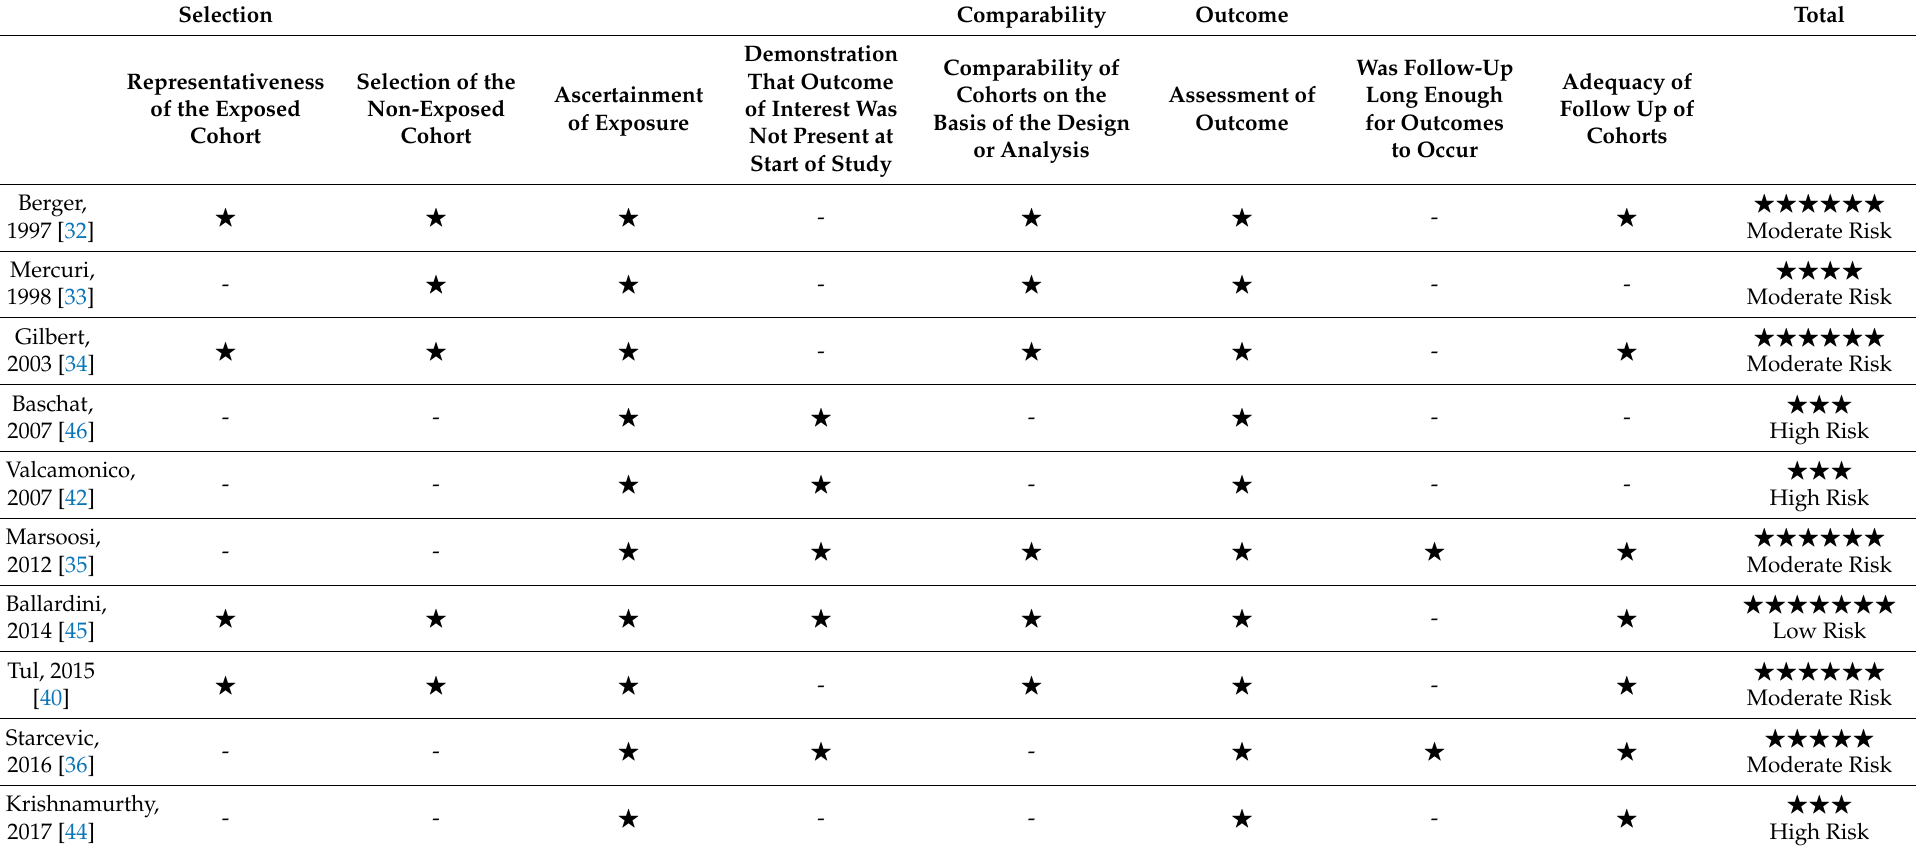
Table 1. Newcastle Ottawa Scale: COHORT STUDIES. Selection of the Ascertainment Non-Exposed of Exposure Cohort